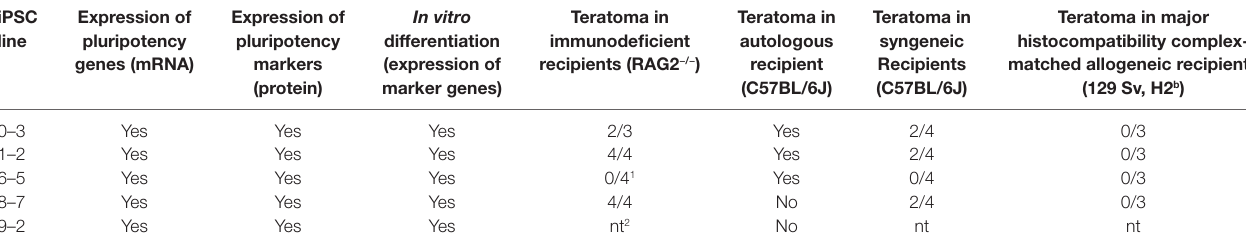
TaBle 1 | Features of induced pluripotent stem cell (iPSC) lines generated for testing teratoma growth in autologous recipients. iPsc